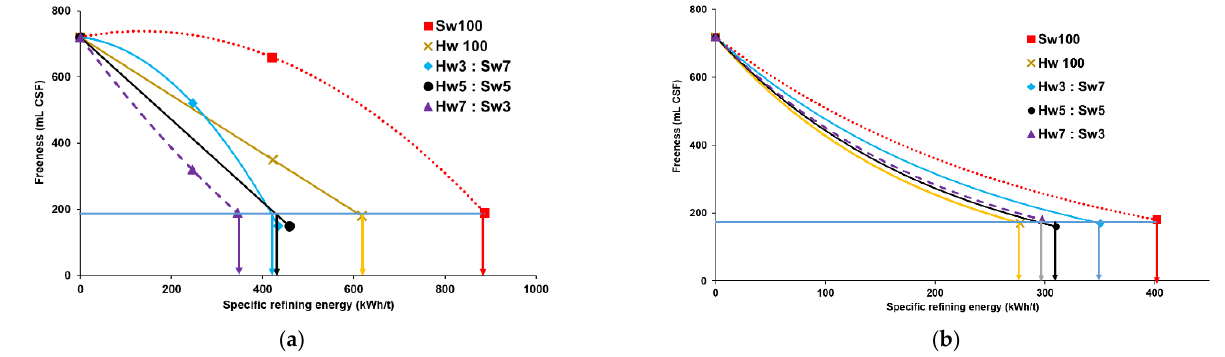
Figure 6. Effect of CEL on freeness drop of the mixed pulps: ( a ) PA55; ( b ) PB97.